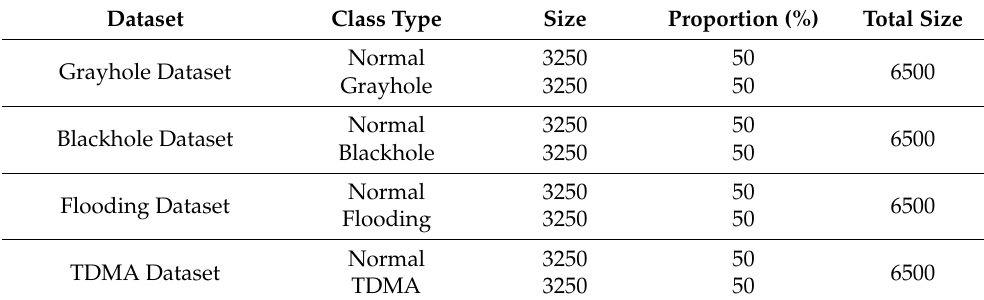
Table 2. Extracted single-class